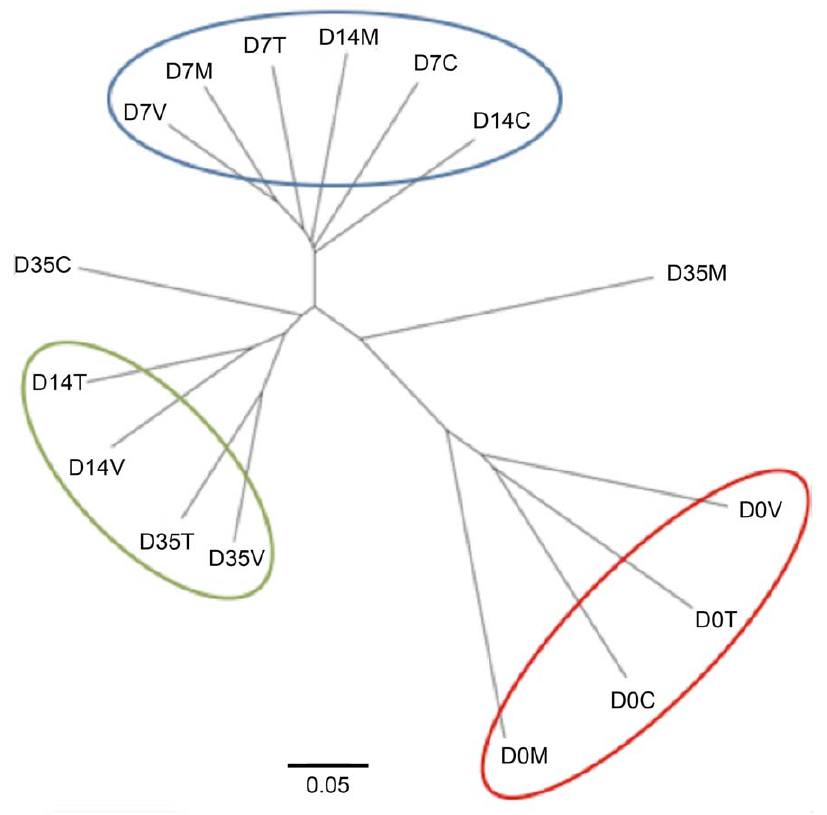
Figure 6. Dendrogram depicting relationships among the experimental groups in this study using OTU analysis, generated using Bray-Curtis index. Circled clusters represent arbitrary groupings showing the groups that are most similar to one another. For each timepoint (D0, D7, D14, and D35), C = control diet, M = monensin treatment, V = monensin/virginiamycin treatment, and T = monensin/tylosin treatment.